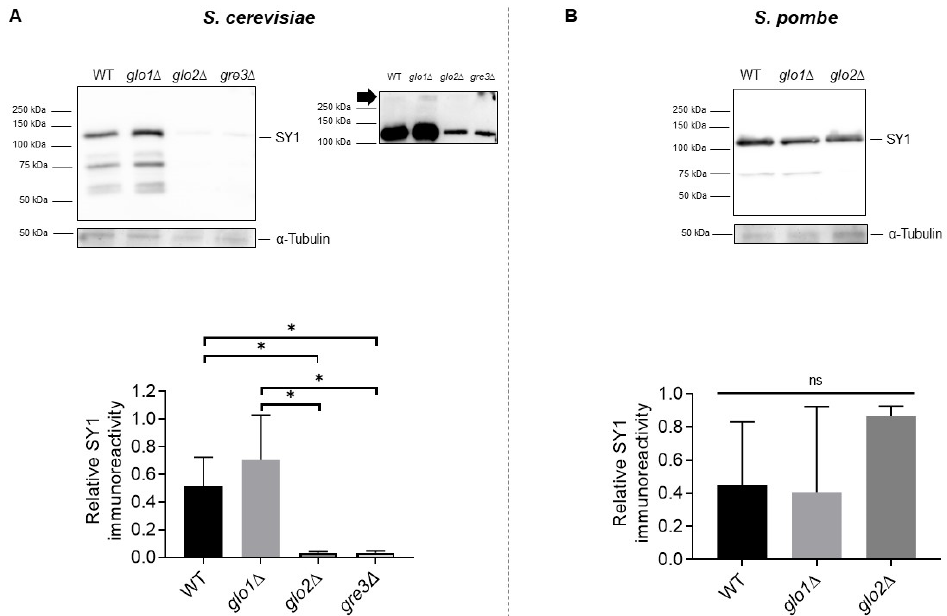
Figure 5. Analysis of SY1 protein level in wt, glo1 ∆ , glo2 ∆ , and gre3 ∆ S. cerevisiae ( A ) and S. pombe ( B ) strains. Protein bands corresponding to SY1 were clearly visible after 30 ″ exposure time (panel A top left), while bands, most likely corresponding to aggregated species, appeared above the 250 kDa protein marker around 2 ′ 30 ″ exposure time (panel A top right, indicated with black arrow). SY1 protein level quantifications are based on densitometric data of three clones per strain and are normalised using the total protein content as determined by anti- α -Tubulin antibody ‘TAT-1 ′ . Error bars represent the standard deviations based on densitometric data of these clones. Significance is determined using a one ‐ way ANOVA test ( p ‐ value of 0.05, significance indicated by the asterisk; n = 3, * = p < 0.05). Non ‐ indicated differences between strains are not significant. SY1 = Synphilin ‐ 1.